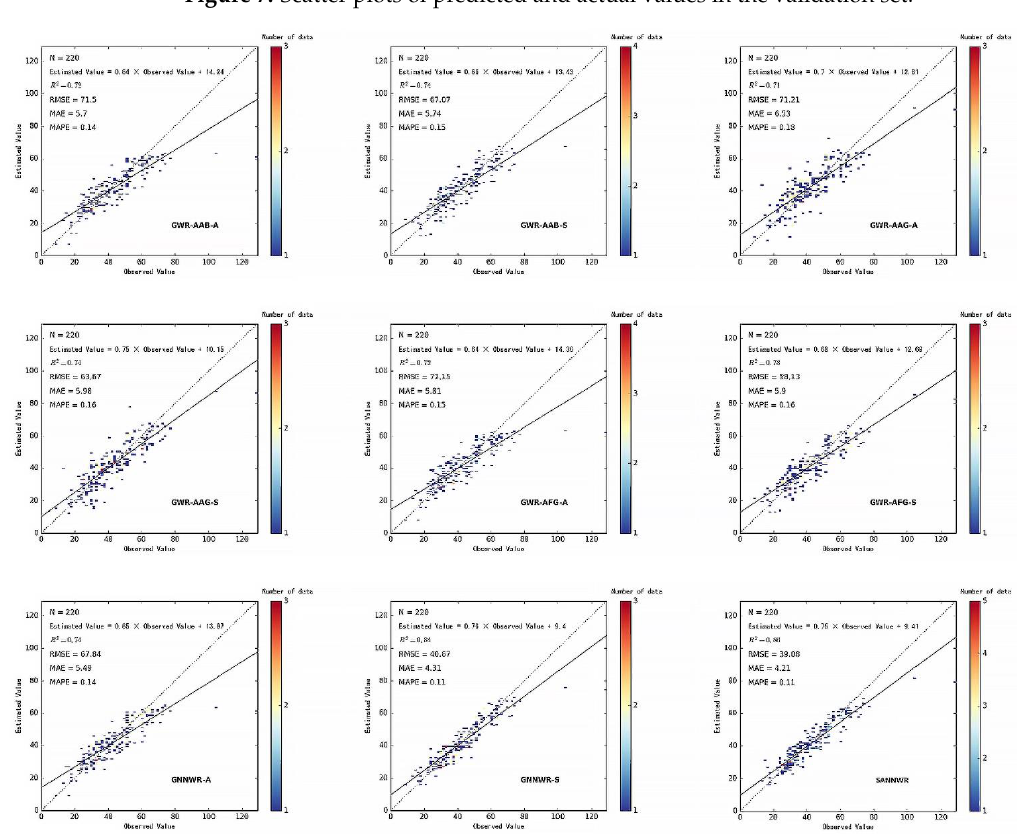
Figure 8. Scatter plots of predicted and actual values in the test